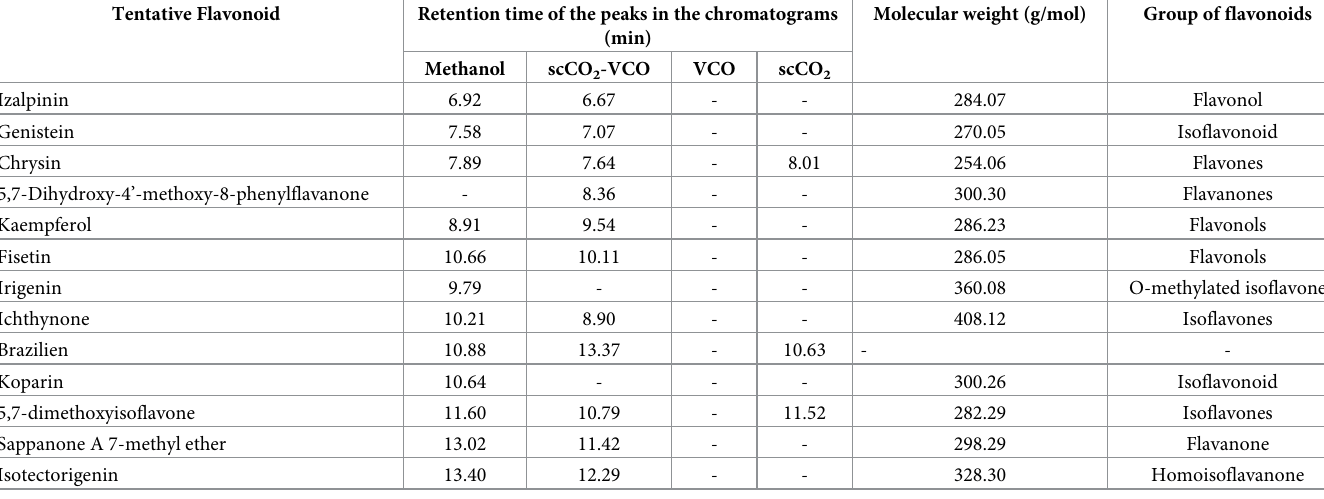
VCO-virgin coconut oil; 20% (w/w) of MeOH or VCO was mixed with propolis powder at 50˚C for 2.5 h; Extraction conditions: supercritical carbon dioxide (scCO 2 ) 150 bar, 50˚C;—compound not